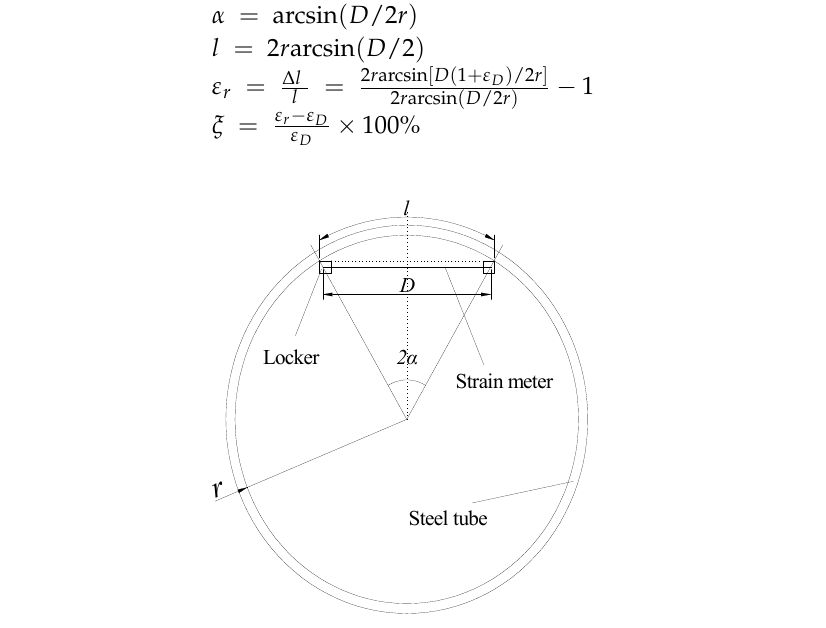
Figure 10. Calculation of measurement error strain meter.